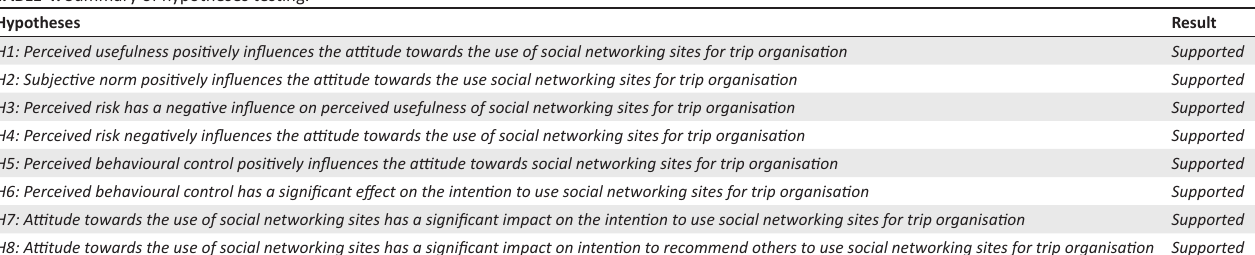
FIGURE 2: Partial Least Squares (PLS) results. TABLE 4: Summary of hypotheses